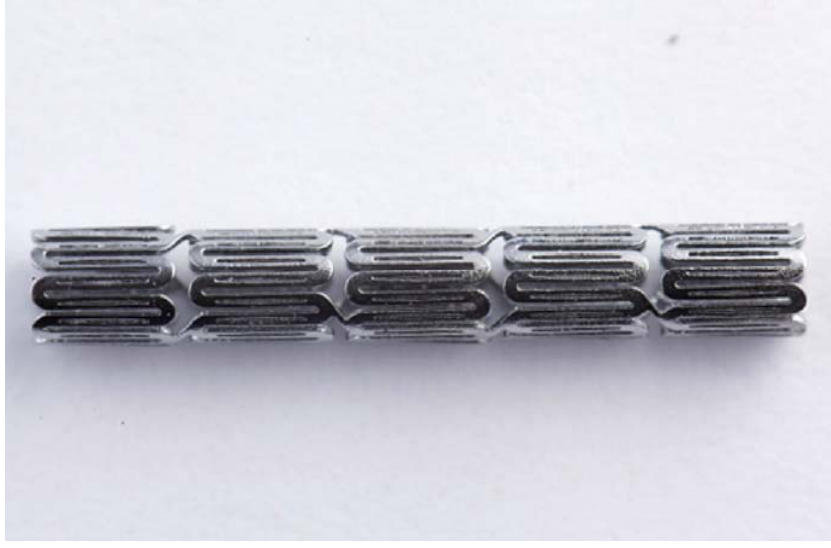
Figure 12. Prototype of our rhombic ‐ shaped channel stent.